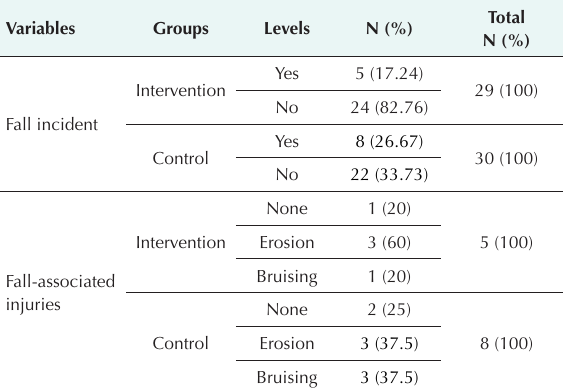
Table 3. The posttest prevalence of fall incident and its associated injuries